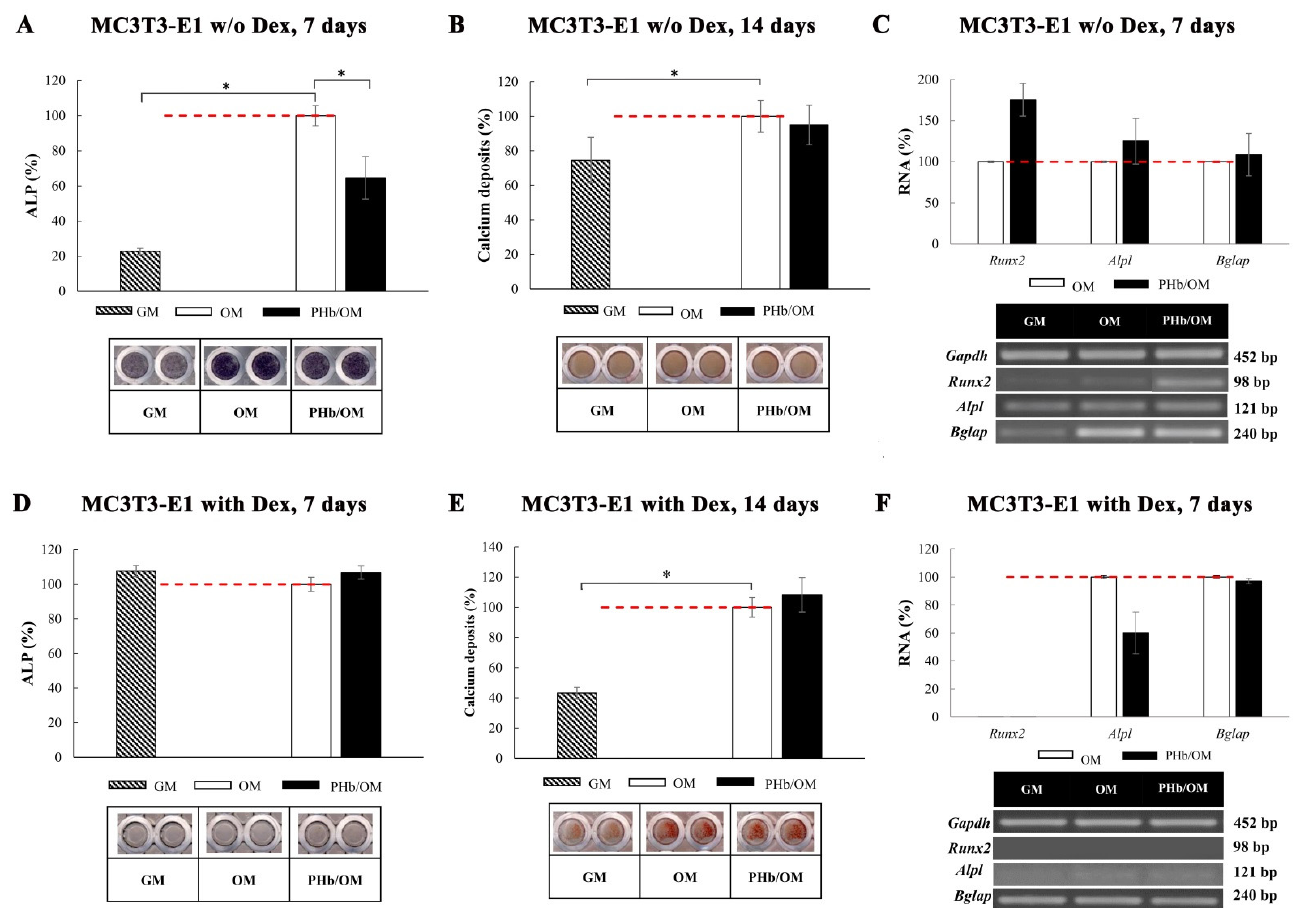
Figure 6. Acellular porcine hemoglobin (PHb) modulates osteogenic differentiation of MC3T3-E1 cells grown in osteogenic medium with or without dexamethasone (Dex). MC3T3-E1 was cultured in osteogenic medium (OM) without ( A – C ) or with ( E , F ) added Dex. The osteogenic differentiation was assessed by ALP staining (NBT/BCIP) after 7 days in culture ( A , D ) and Alizarin red staining after 14 days in culture ( B , E ) with OM with or without PHb. Results of ALP or Alizarin red staining are presented as relative to control (OM set as 100%). Mean ± SD of four independent experiments is shown; * p < 0.05, compared to the control (OM). Osteogenic differentiation of MC3T3-E1 was confirmed by RT-PCR of analysis of expression of Runx2 , Alpl , and Bglap genes after cultivating cells in OM with and without PHb for 7 days ( C , F ). GAPDH was used as a gel loading control. Representative RT-PCR bands are shown. RT-PCR results are expressed as relative to corresponding control (OM, set as 100%). Mean ± SD of three independent experiments is shown.